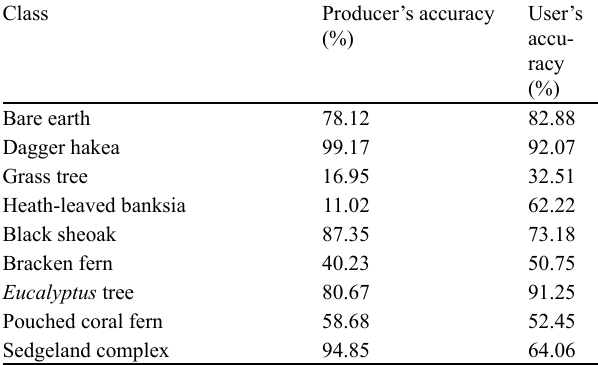
Table 3 Class wise accuracy of best classification method